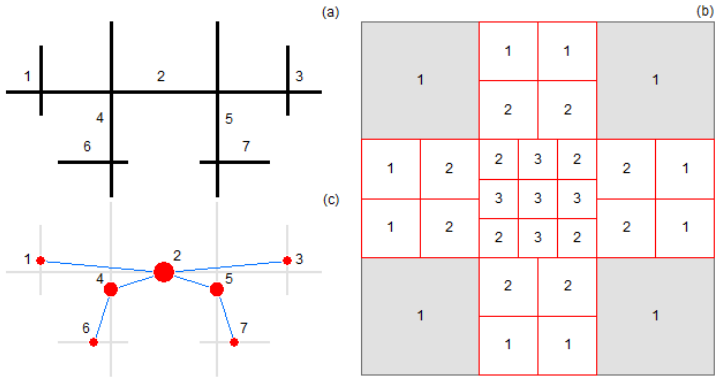
Figure 5. (Color online) Illustration of concepts of natural streets and a natural city. Note: The seven natural streets, indicated by numbers in panel ( a ), are created from 19 street segments, while the one natural city is created from the 25 city blocks, which are red in panel ( b ). There are far more less-connected streets than well-connected ones, and far more small street blocks (or city blocks) than large ones. In panel ( c ), the seven streets and their six intersections are converted into the seven nodes and six links of the connectivity graph; the dot sizes show the degrees of connectivity. The 25 city blocks and the four large street blocks (or field blocks in gray) in panel ( b ) constitute the fictitious country as a whole. The numbers shown in the blocks indicate how topologically far the blocks are from the country’s border, or the border number.